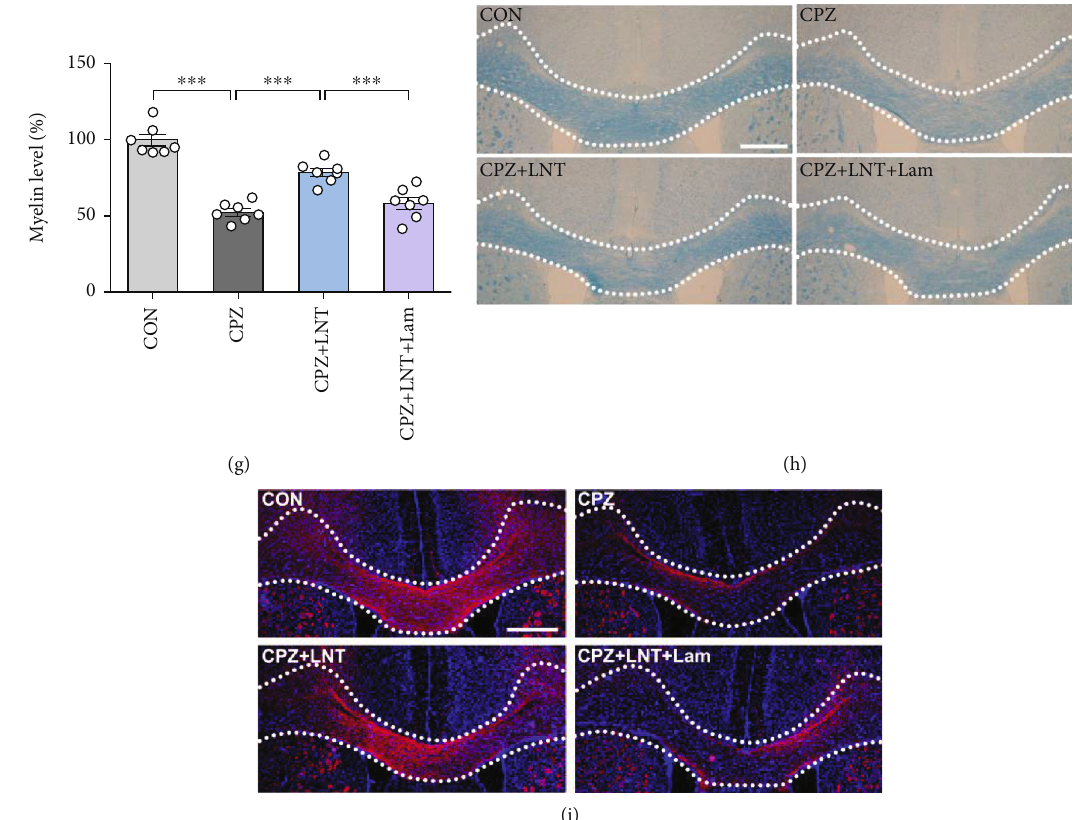
Figure 5: LNT promoted myelin regeneration by regulating the dectin-1 receptor. (a) Scheme of the experimental protocol of LNT and Lam treatment. (b) Rotarod test. The latency time of each group to stay on the rotarod was recorded. (c) Immunostaining of dectin-1 in the corpus callosum. (d) The protein level of dectin-1 was detected by Western blot. (e) Histogram of quantitative data of dectin-1-positive cells. (f) A histogram of quantitative data of MBP immuno fl uorescence staining in the corpus callosum. (g) A histogram of